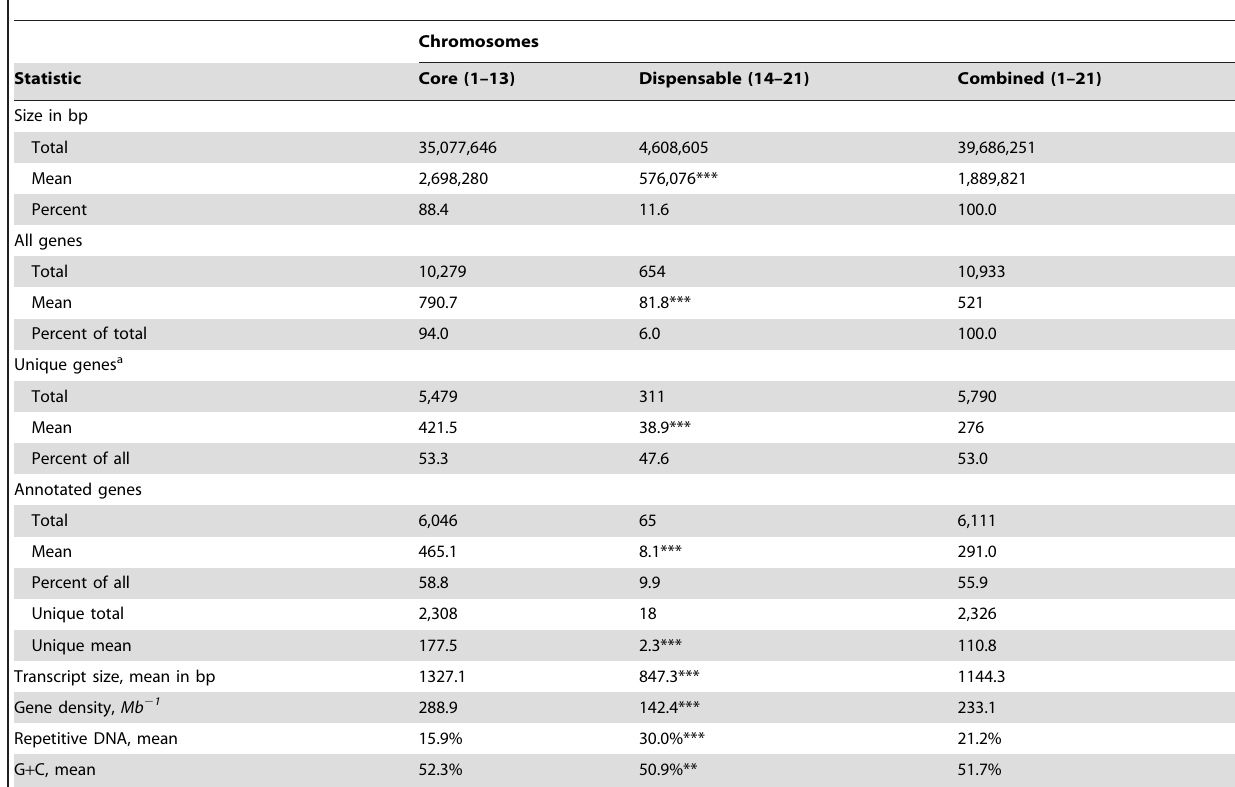
Table 2. Differences between essential and dispensable chromosomes in the genome of Mycosphaerella graminicola isolate